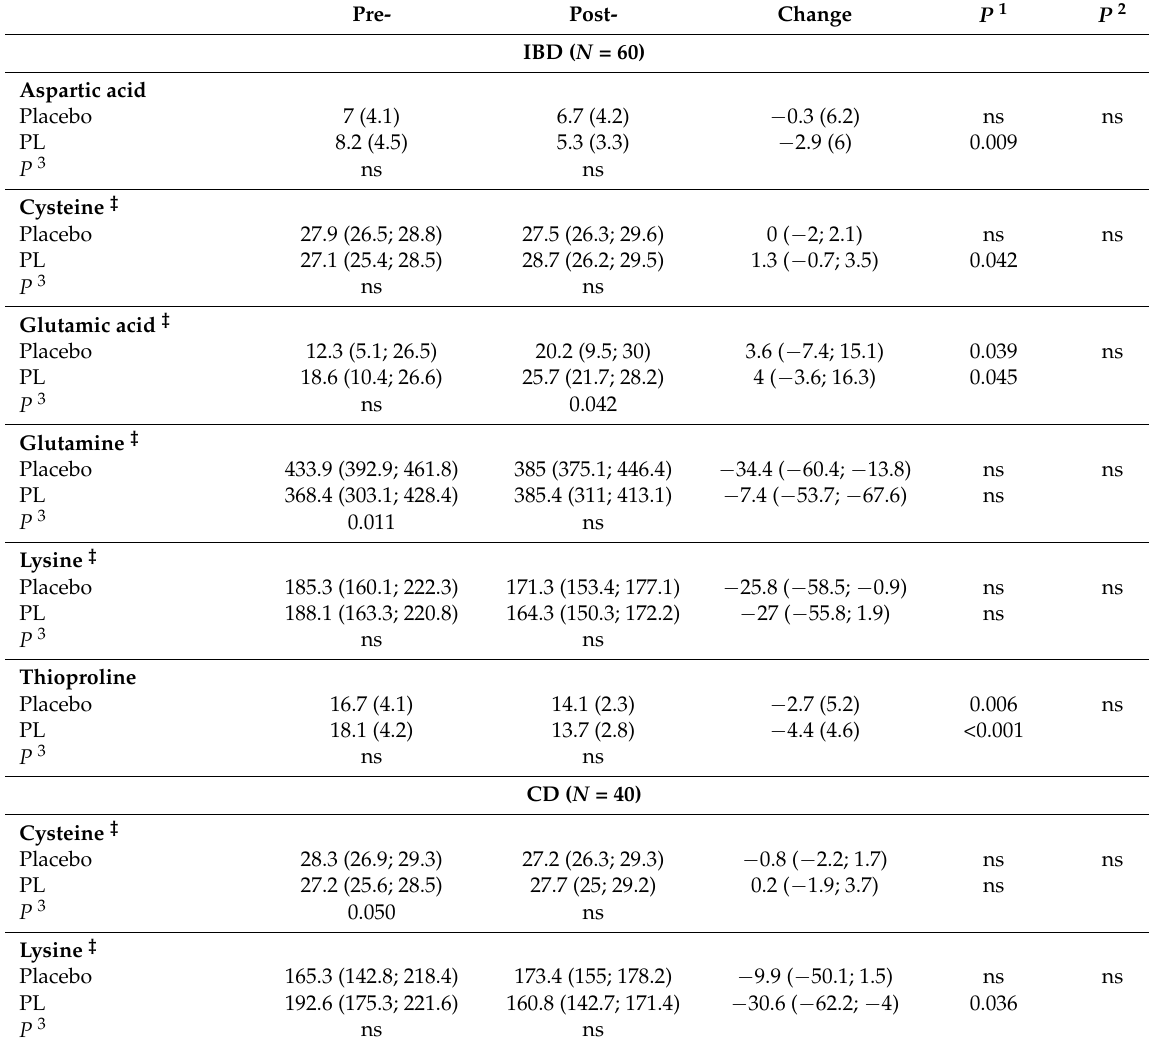
Table 4. Significant differences in amino acids (AAs) levels (nmoL/mL). Values are expressed as the mean (SD) or median (interquartile range,